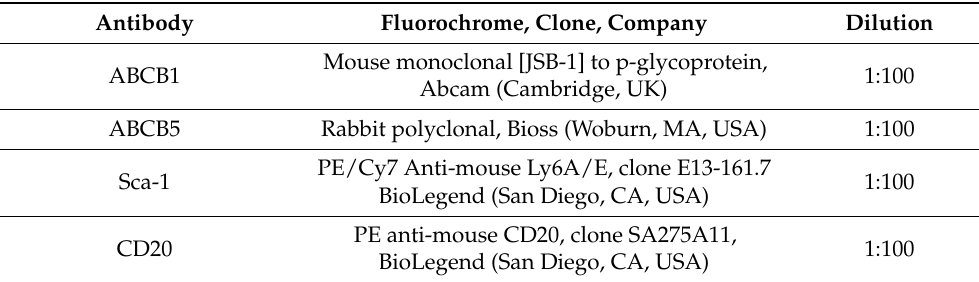
Table 1. Antibodies used for flow cytometry analysis. Antibody Fluorochrome, Clone, Company Dilution Mouse monoclonal [JSB-1] to p-glycoprotein, ABCB1 Abcam (Cambridge, UK)